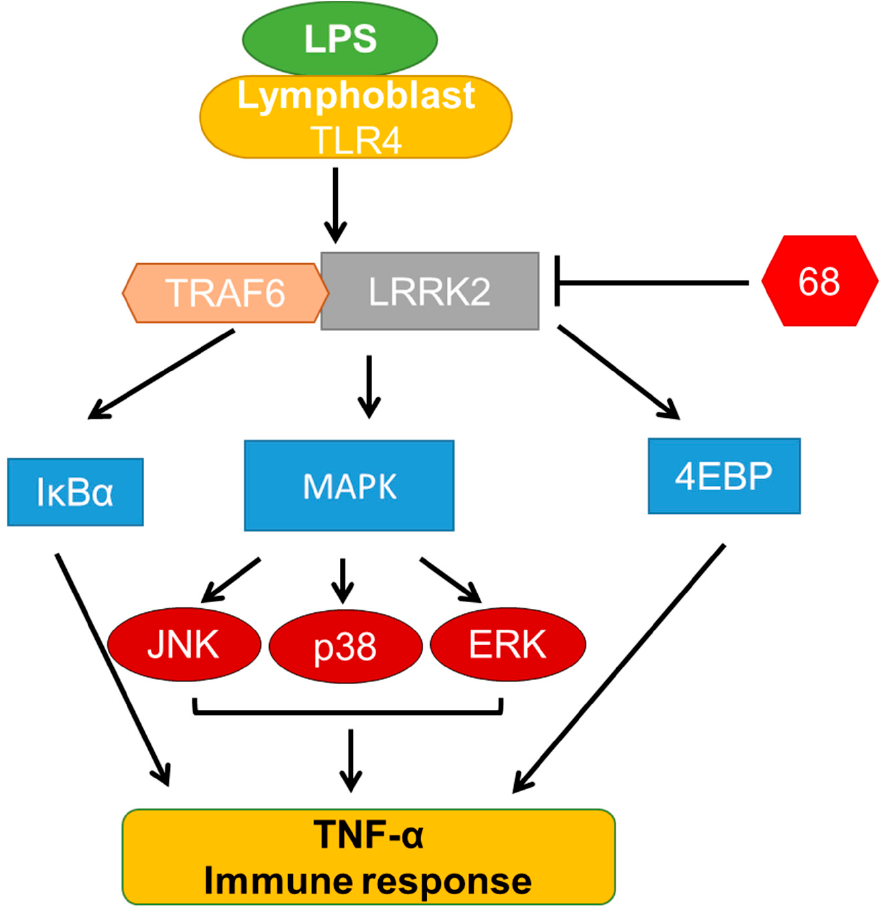
Figure 7. Proposed 68 action model in LPS-induced signaling pathways and TNF- α release.